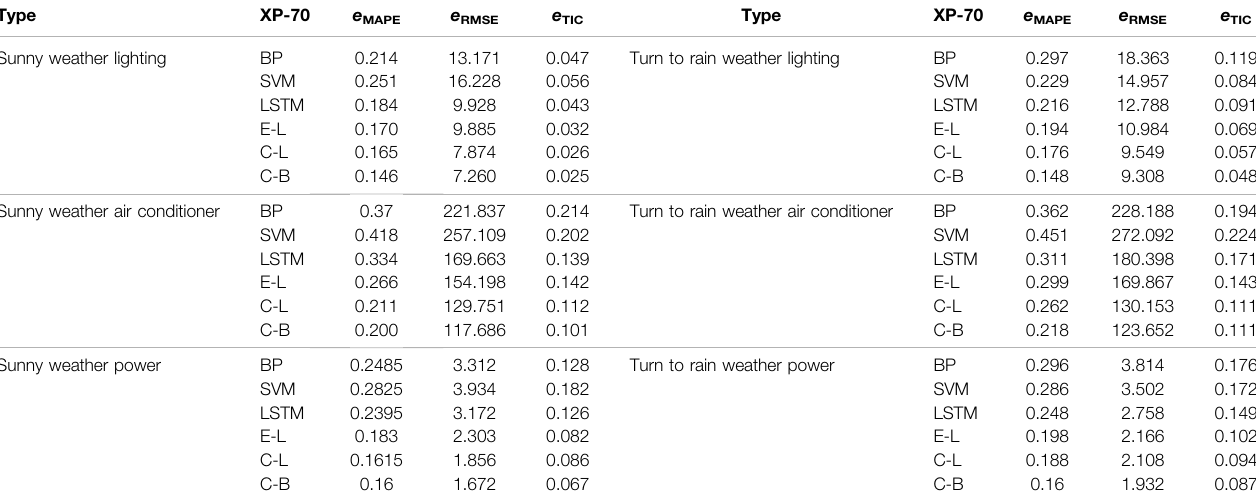
TABLE 1 | Prediction errors of different models. Type Sunny weather